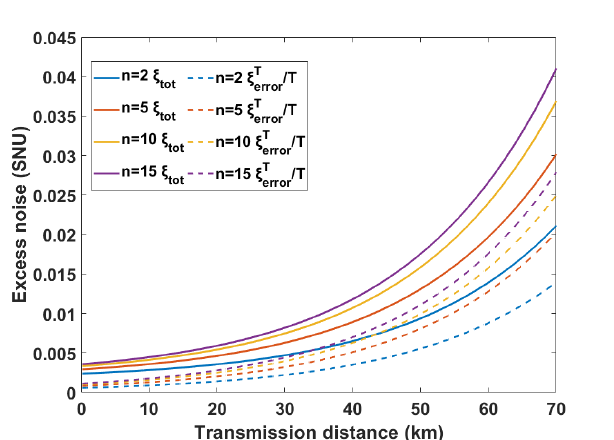
Figure 3. The excess noise (solid lines) and the partially trusted phase noise for n ∈ { 2,5,10,15 }